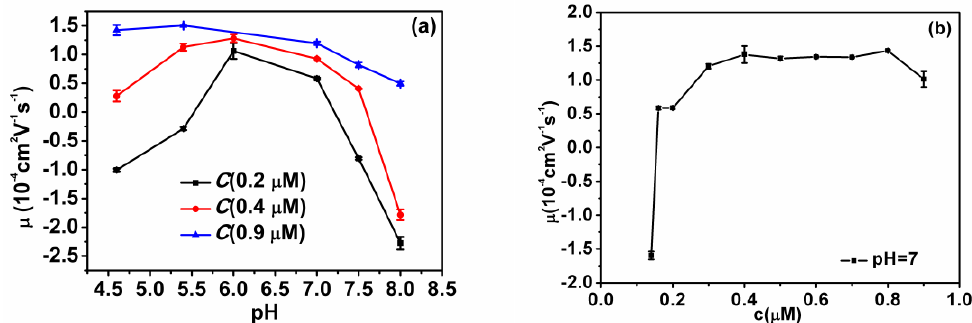
Figure 2. ( a ) Electrophoretic mobility of DNA-chitosan complexes as a function of pH of solutions at various chitosan concentrations (0.2 µM, 0.4 µM, 0.9 µM; corresponding, k are 1.9, 3.8 and 8.55). ( b ) Electrophoretic mobility of DNA-chitosan complexes as a function of chitosan concentration at pH = 7. The concentration of DNA is 1 ng µL − 1 .